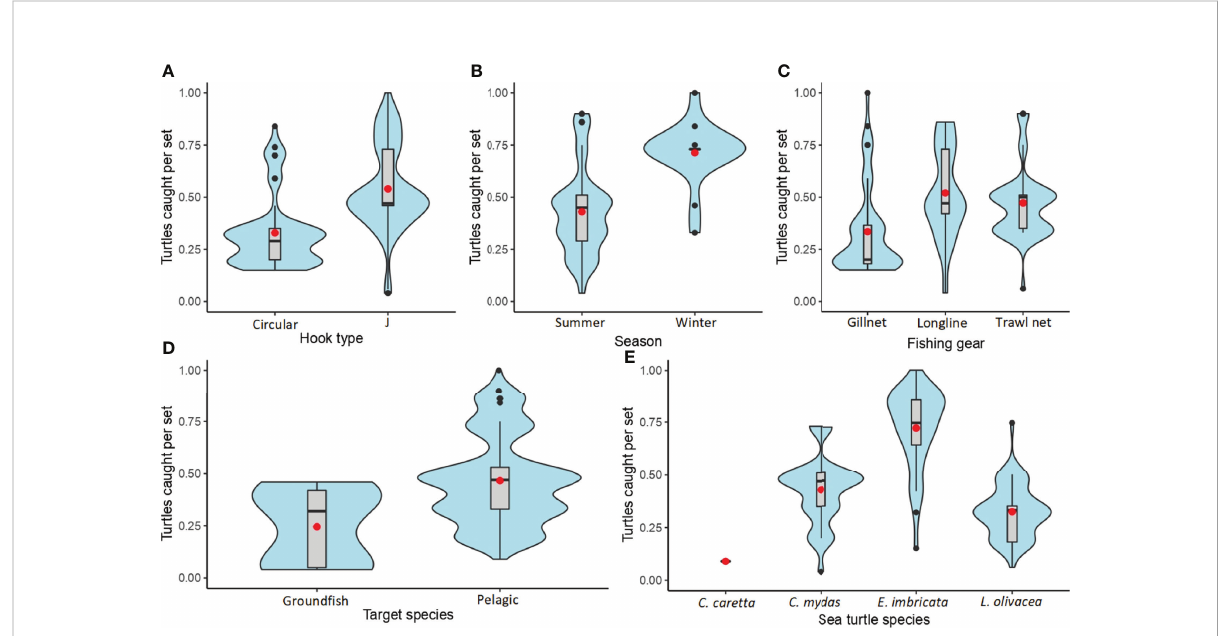
FIGURE 3 Violin plots of the predicted values of the number of sea turtle by-catch according to: (A) hook type (B) season (C) fi shing gear (D) target species and (E) sea turtle species, according to the fi shers ’ data (model 2). The thick grey bar in the center represents the interquartile range and the width of the violin represents the sample size. Red point and horizontal black line represent mean and median